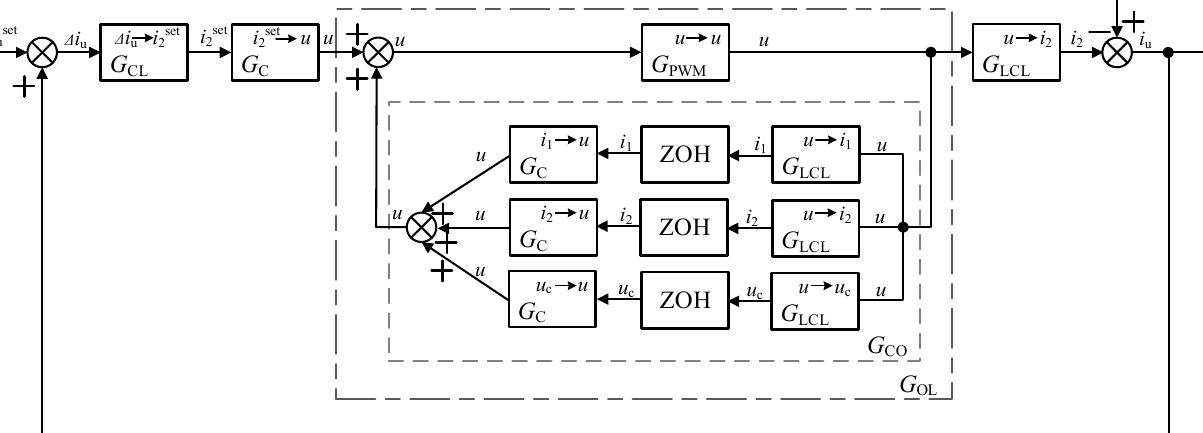
Figure 7. Z -domain control block diagram.